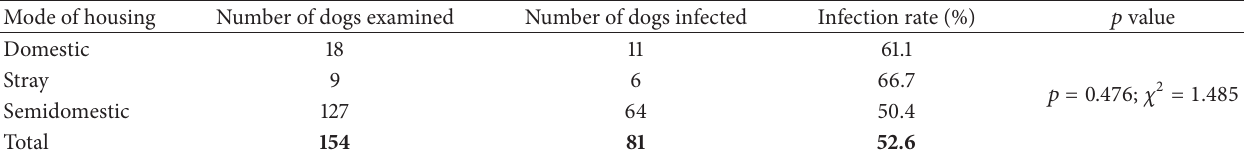
Table 3: Prevalence of helminths in relation to mode of